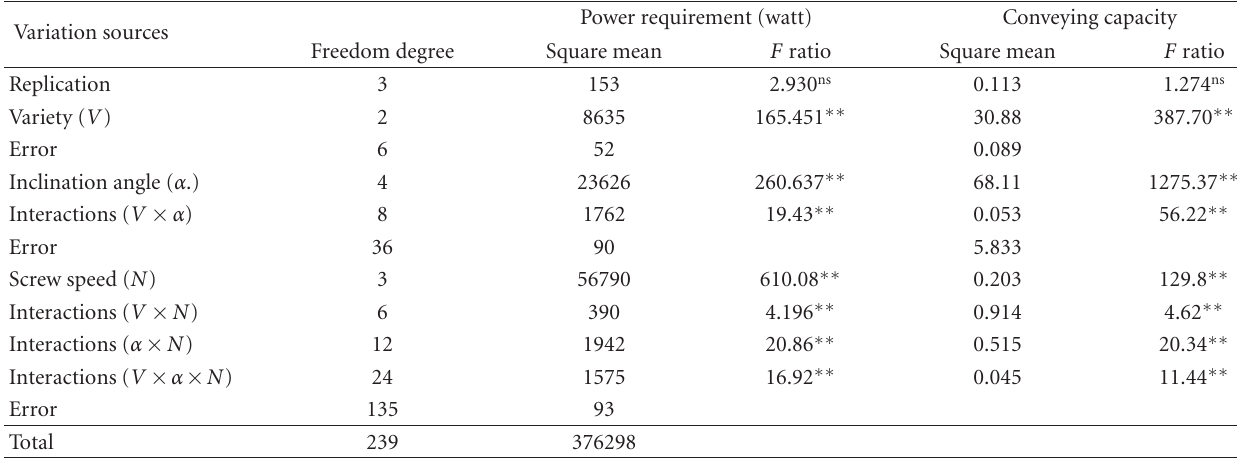
Table 1: Variance analysis of power requirement and convening capacity.